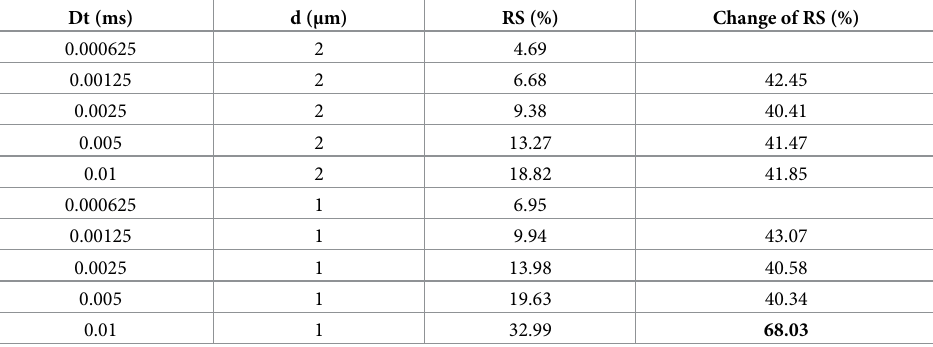
ffiffiffi p For doubling Dt the theory predicts an increase of 2 that is 41,42%. This principle holds as long as Dt is not too large. For the last case (bold value), d = 1 μ m and Dt = 0.01ms, the rule did not hold since Dt is too coarse and thinner fibers are significantly noisier than thicker ones. Dt > 0.0025ms is generally not recommended. Simulated for electrode distance z = 1 mm, knoise = 0.001, HH10 model, 1000 runs per